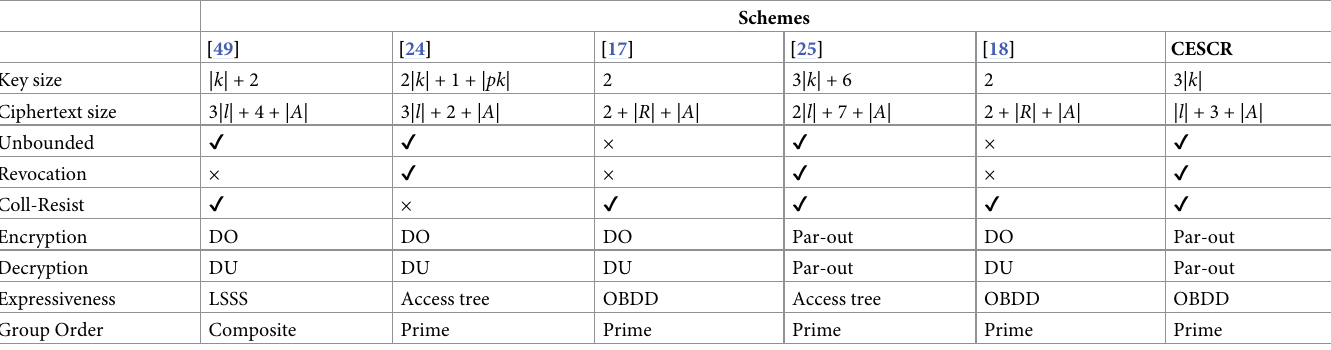
Table 1. Feature and storage comparison of CP-ABE schemes.